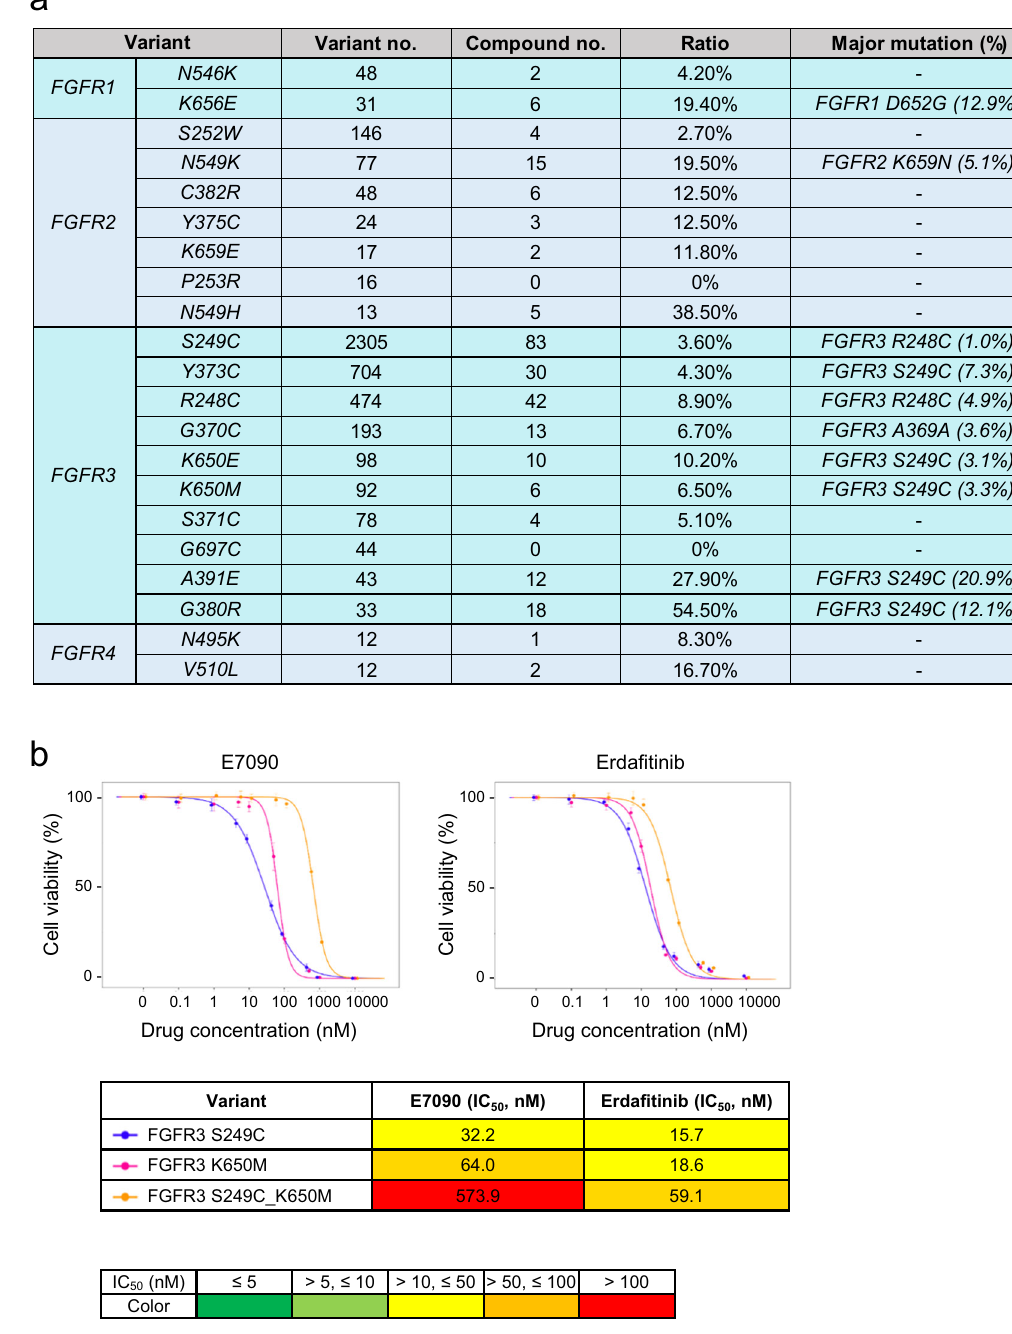
Fig. 7 Functional analysis of FGFR compound mutations. a The frequency and patterns of FGFR compound mutations were investigated in the hotspot variants of FGFRs in the COSMIC database. b The drug sensitivity of FGFR compound mutations was evaluated with the PrestoBlue cell viability assay. 3T3 cells expressing a FGFR single mutation and compound mutations were treated with the indicated concentrations of E7090 or erda fi tinib for 5 days. Cell viability was measured using the PrestoBlue cell viability assay and plotted relative to the untreated controls. Data are presented as the mean ± SD ( n = 6). Estimated IC 50 values are shown in the tables under the dose response curves. error bars, dimethyl sulfoxide (DMSO)-treated cell mixtures were used as the reference control for scaling the bar code count of each clone. The relative growth inhibition of each cell clone was calculated as the ratio of the average read number across triplicates to that of the DMSO control. All inhibitors used in the assay, except E7090 (provided from Eisai Co., Ltd., Tokyo, Japan), were commercially purchased: dovitinib, AZD4547,